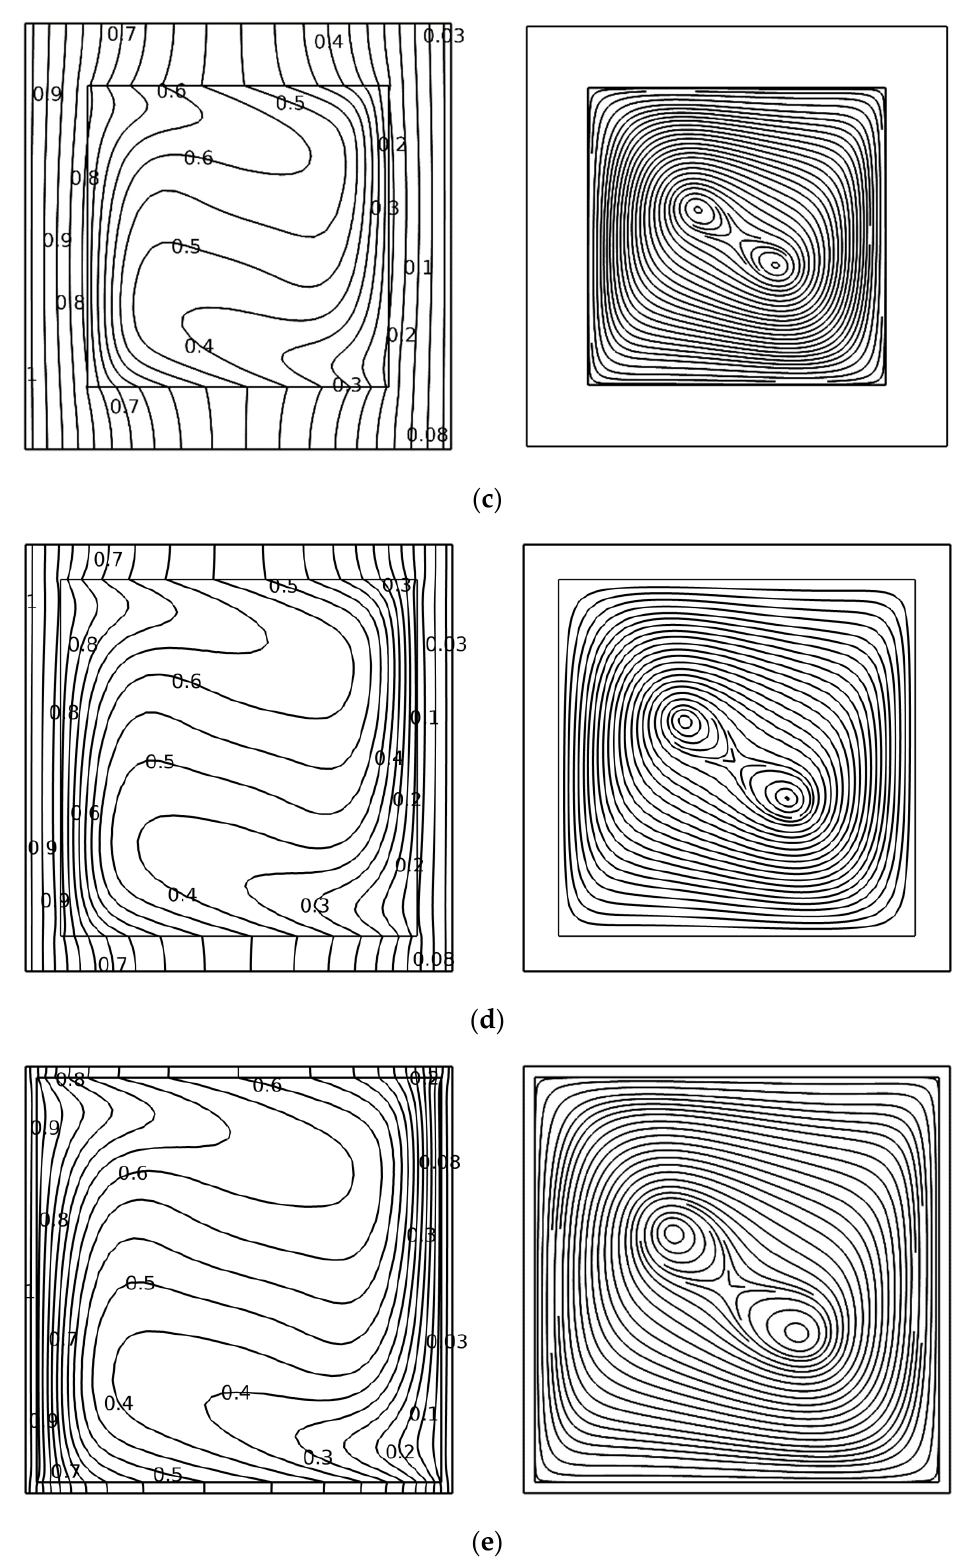
Figure 12. Streamlines and isothermals obtained for ( a ) φ = 0.1, W max = 59.963, ( b ) φ = 0.3, W max = 63.882, ( c ) φ = 0.5, W max = 66.759, ( d ) φ = 0.7, W max = 70.289 and ( e ) φ = 0.9, W max = 74.105.